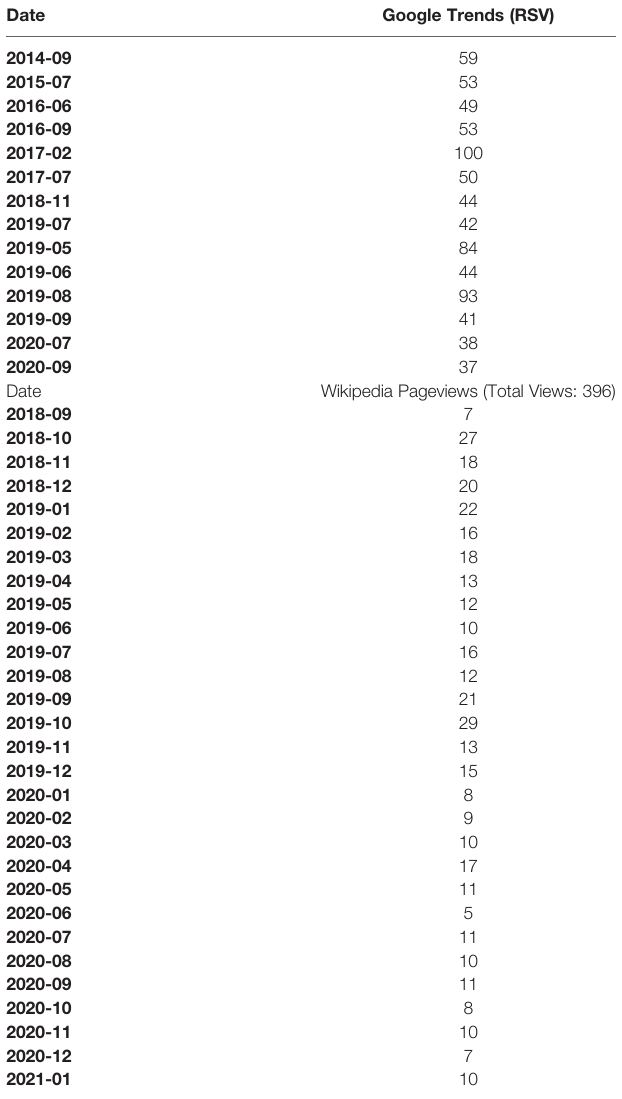
TABLE 4 | Infodemiological data on using “ Tumor Treating Field ” as a search